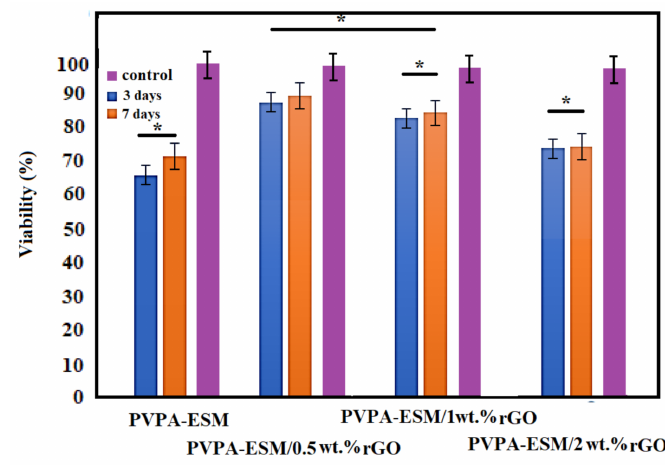
Figure 9. Cell viability of PVPA–ESM/x wt.% rGO nanofibers with various rGO concentrations (x = 0, 0.5, 1 and 2 wt.%) (* not significantly difference between various samples, p >